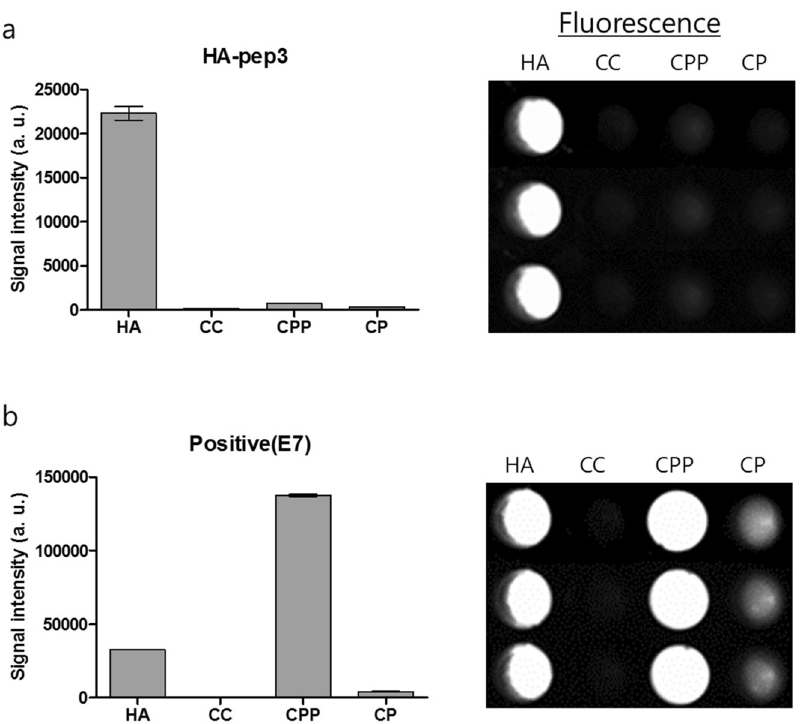
Figure 5. The specificity of ( a ) the HA-pep3 and ( b ) acidic oligopeptide as positive peptide for the biologically relevant calcium salts. HA = hydroxyapatite, CC = calcium carbonate, CPP = calcium pyrophosphate, CP = calcium